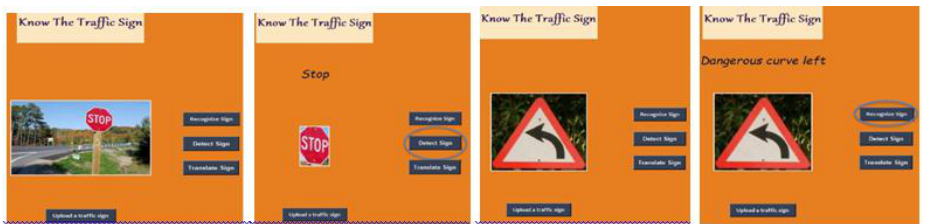
Fig. 13. GUI showing traffic sign detection, recognition and translation buttons.